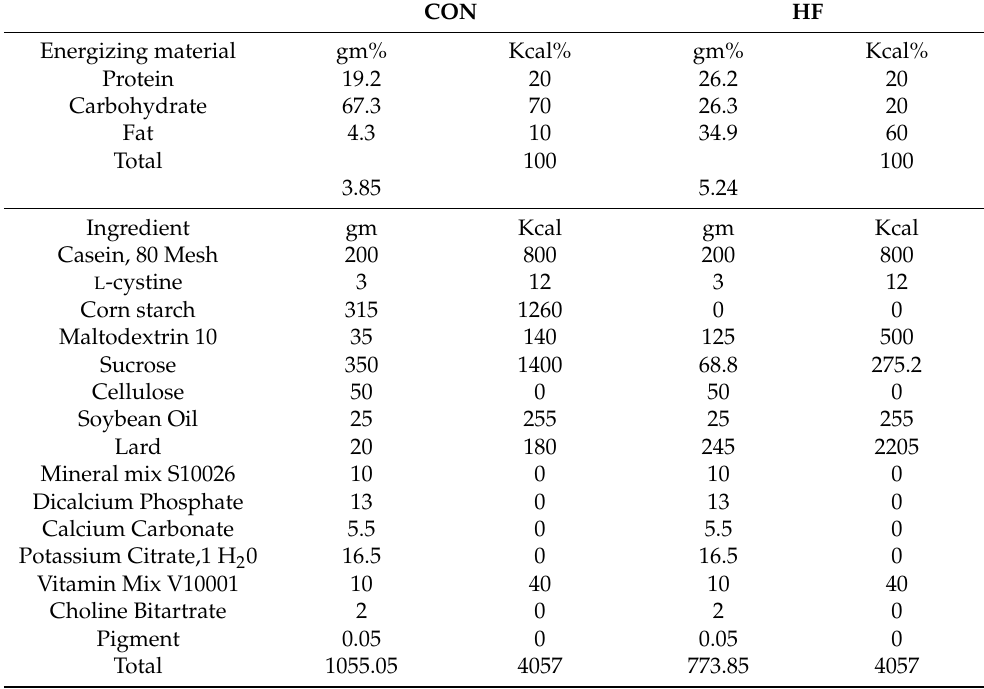
Table 1. Composition and nutrient content of the experimental